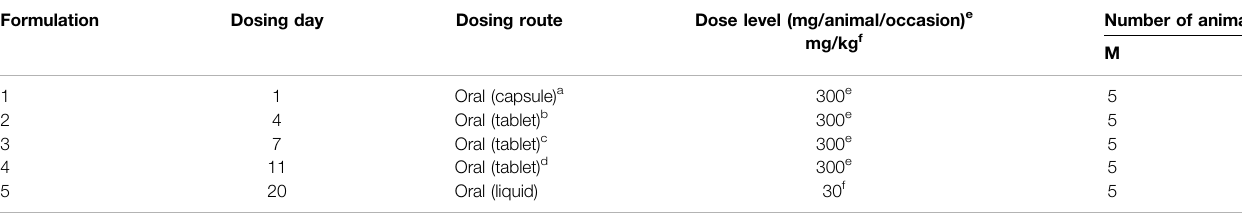
TABLE 1 | Overview of zapnometinib formulations used in the beagle dog study. Formulation Dosing day Dosing